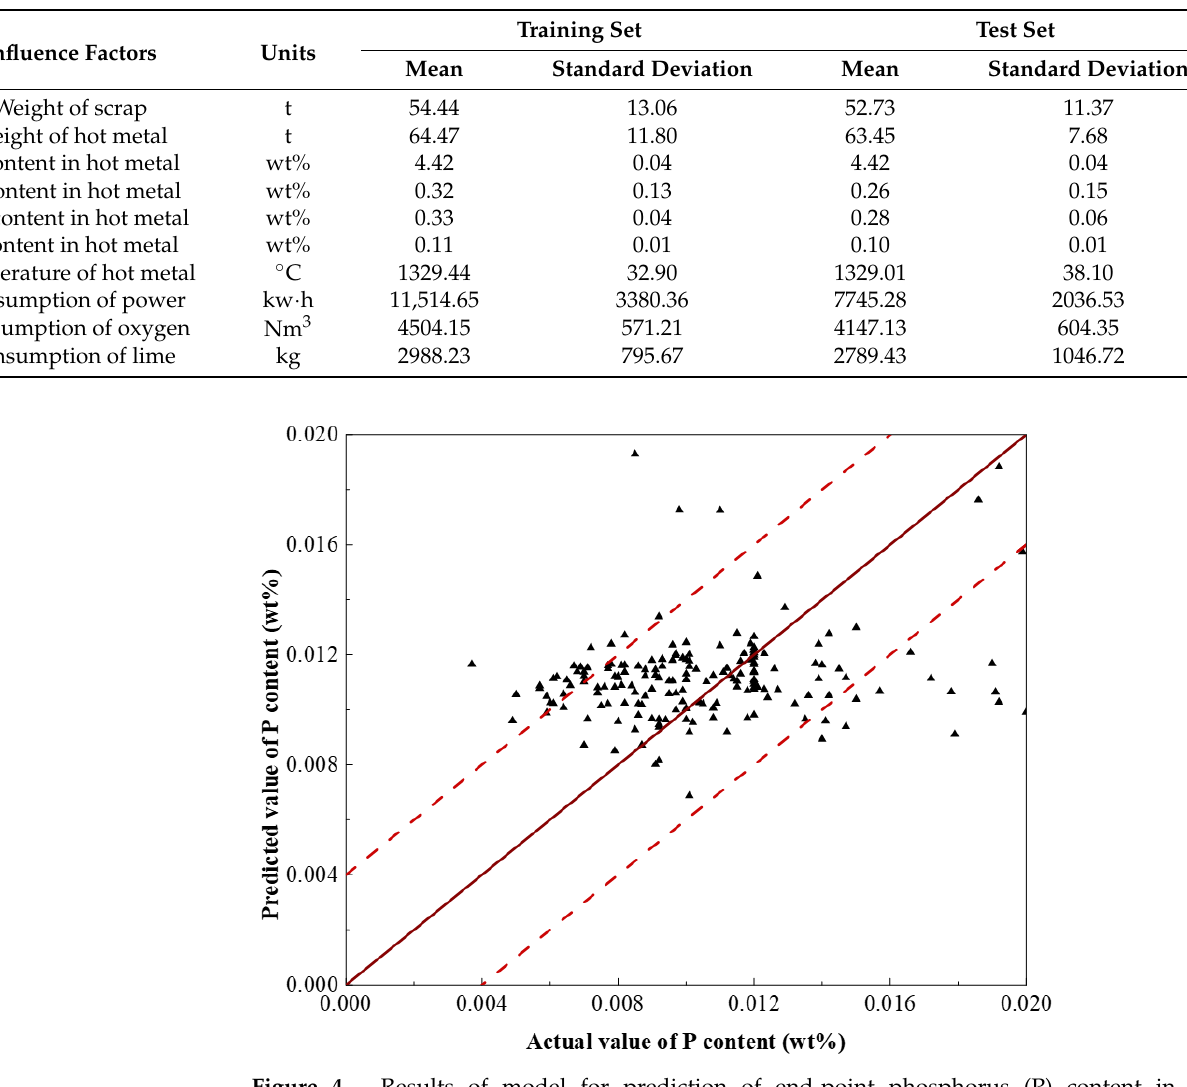
Figure 4. Results of model for prediction of end-point phosphorus (P) content in EAF steelmaking process. Figure 5 indicates that the absolute deviation of the model is 28.89%, 48.33%, 65.56%, 77.22%, and 88.89% when the predictive errors are within ± 0.001 (wt%), ± 0.002 (wt%), ± 0.003 (wt%), ± 0.004 (wt%), and ± 0.005 (wt%), respectively. The absolute deviation when the error is within ± 0.004 (wt%) and below, which affects the guidance of actual production. However, the frequency when the error is within ± 0.004 (wt%) and below is less than 80%. Poor accuracy meant the model is not qualified for the role to regulate the actual production. There is still room for the improvement of the prediction